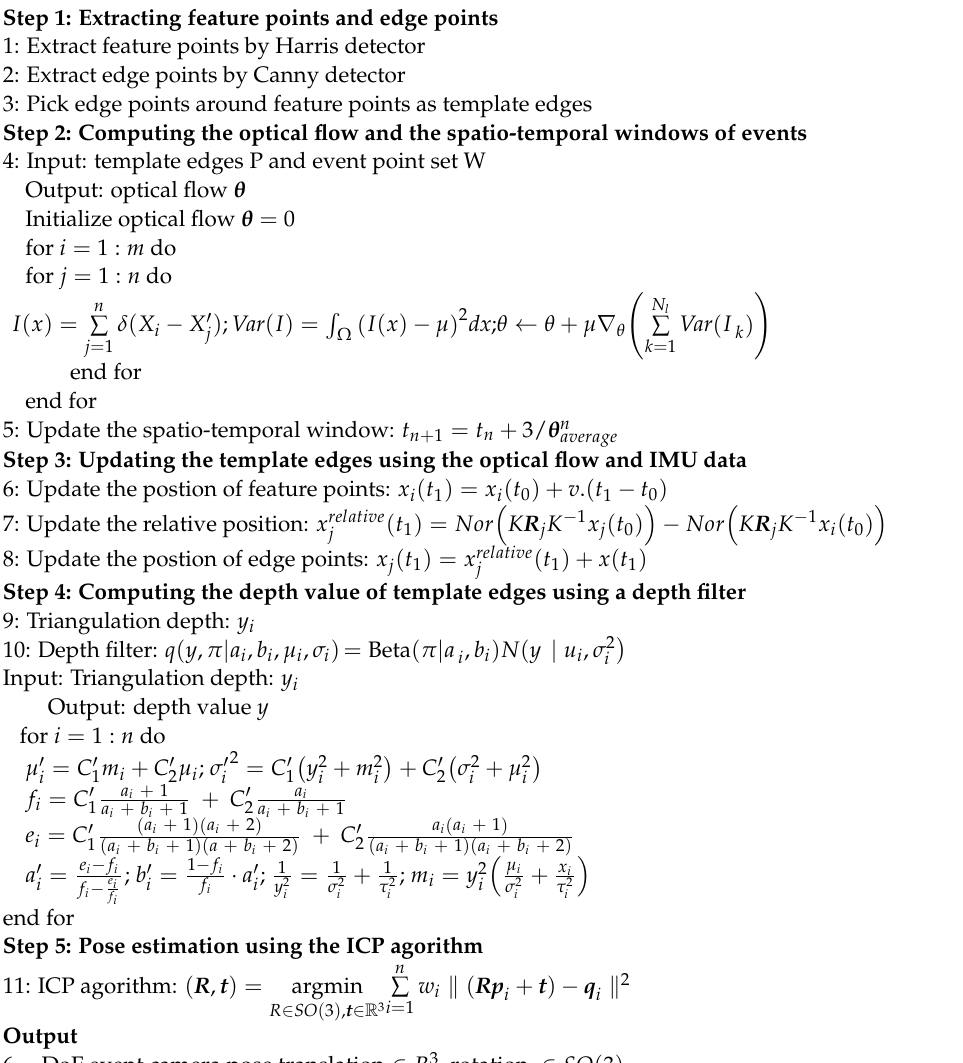
Algorithm 1: Pseudo-code of pose